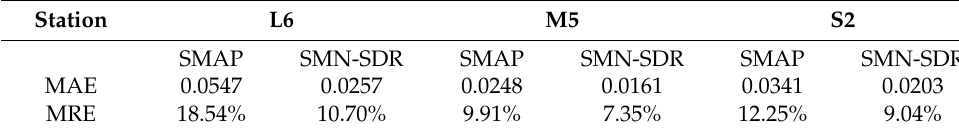
Table 5. Evaluation of downscaling results of time series.